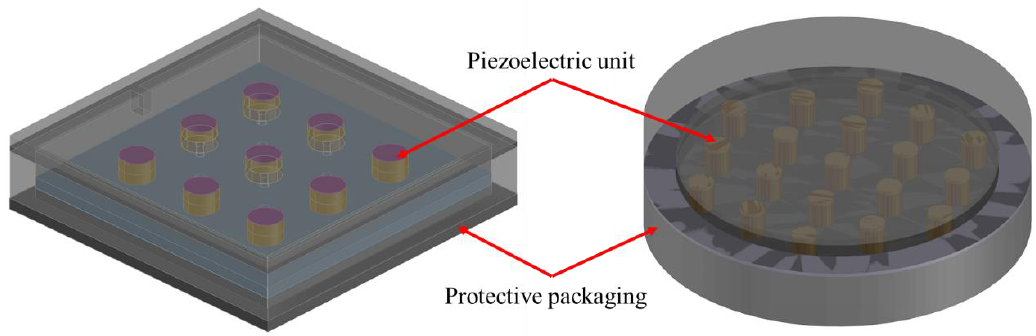
Figure 2. The PEH designed for road energy harvesting.